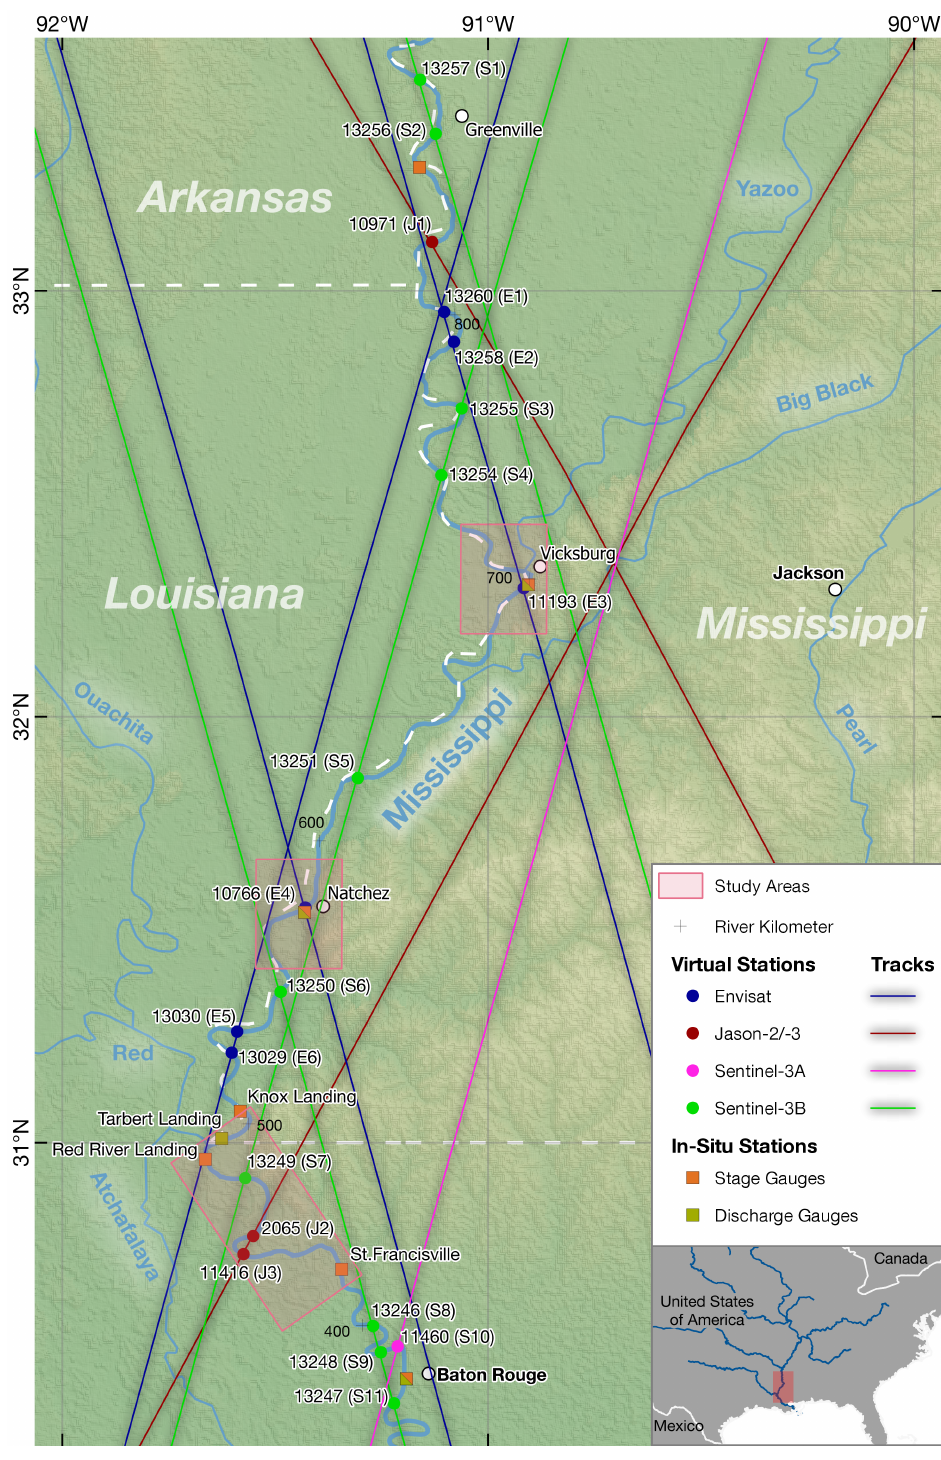
Figure 1. Overview of study areas, discharge and water level gauge locations, satellite altimetry tracks, and virtual stations with the DAHITI identifier and the short identifier used in this paper